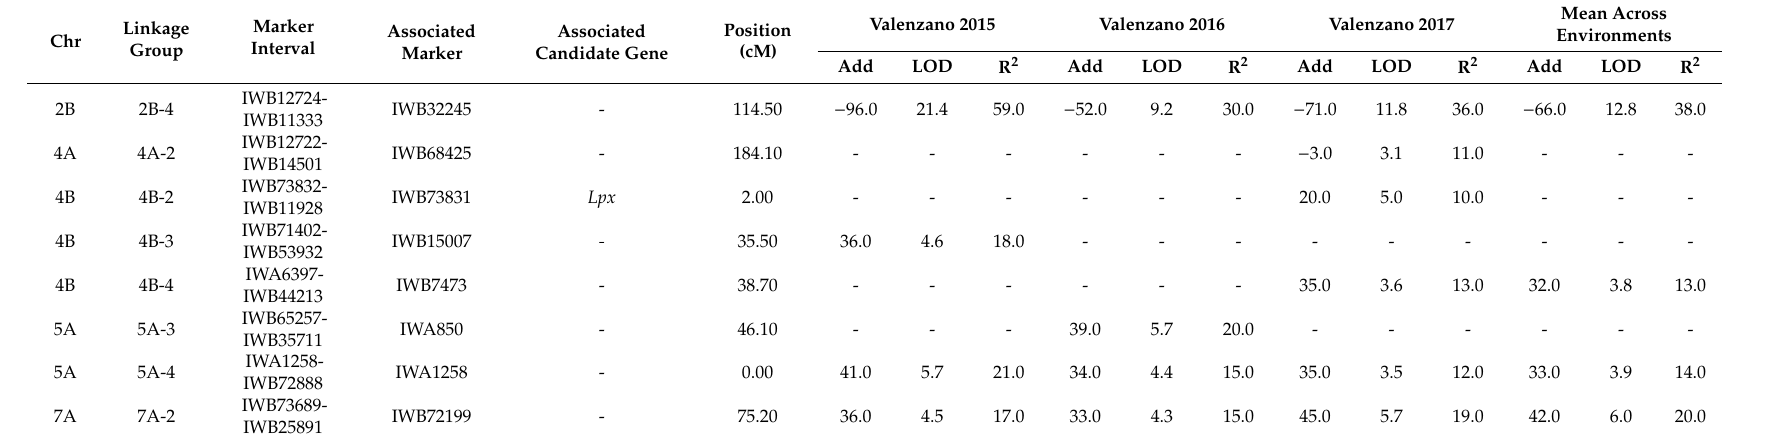
Table 2. Composite interval mapping results estimated for yellow index (YI) from RIL lines derived from the cross “02-5B-318” x “Saragolla” tested at Valenzano in 2015, 2016, and